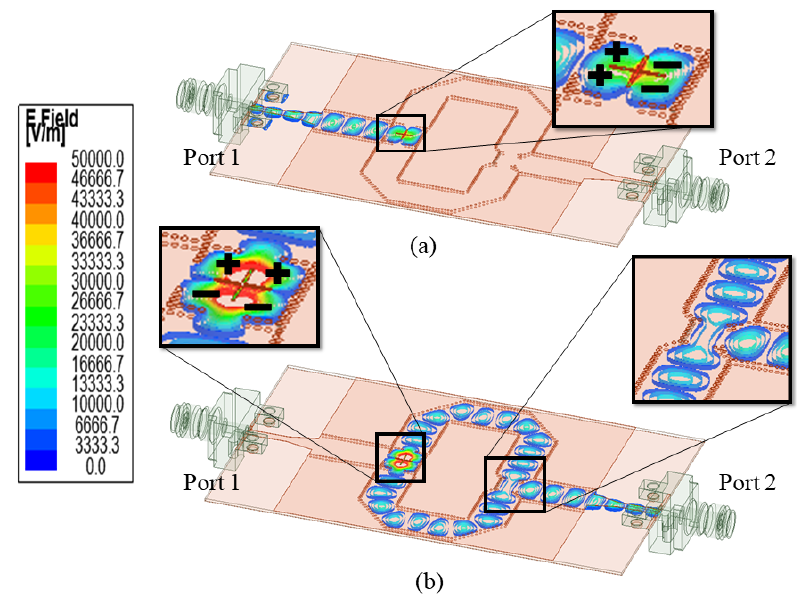
Figure 9. Modes (electric field) intensity for combined antenna system at 28 GHz, ( a ) excitation from port 1, ( b ) excitation from port 2 [red and blue show highest and lowest intensity,